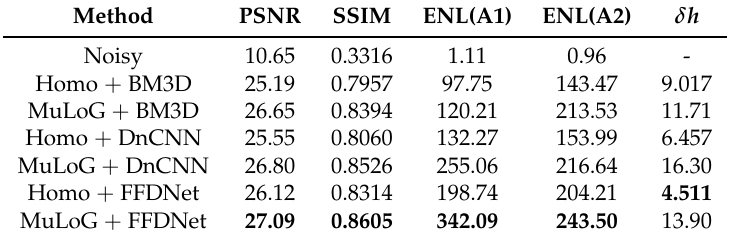
Table 1. The quantitative comparison of different methods for simulated SAR image with L = 1.